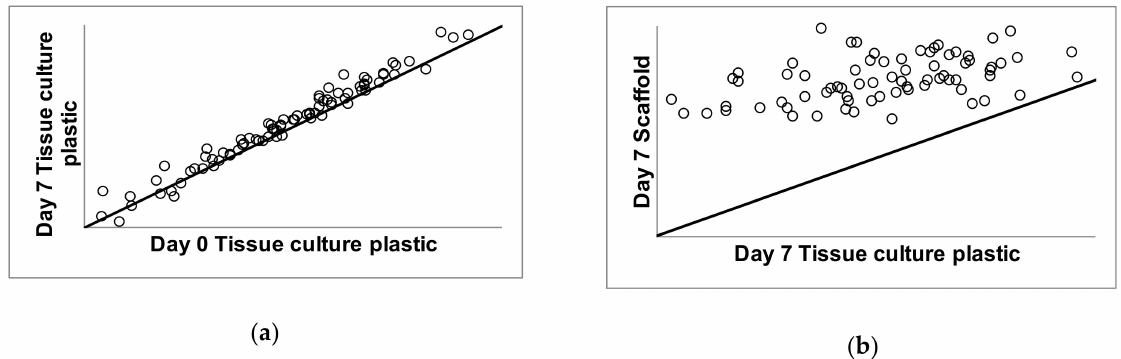
Figure 9. Correlation analysis of gene expression during growth on tissue culture plastic and cartilage scaffold. C28/I2 cells were grown under conventional conditions on tissue culture plastic for one week ( a ) and compared to cells grown on cartilage scaffold for 7 days ( b ). The diagonal line in ( a , b ) indicates the trend expected if there was no change between conditions; day 0 versus day 7 on tissue culture plastic in ( a ) and day 7 on tissue culture plastic versus day 7 on cartilage scaffold in ( b ). Data points above the line reflect genes expressed at higher levels on the cartilage scaffold compared to plastic. Data points below the line indicate genes that were expressed at higher levels on plastic compared to the cartilage scaffold. Data points that fall on the line were not